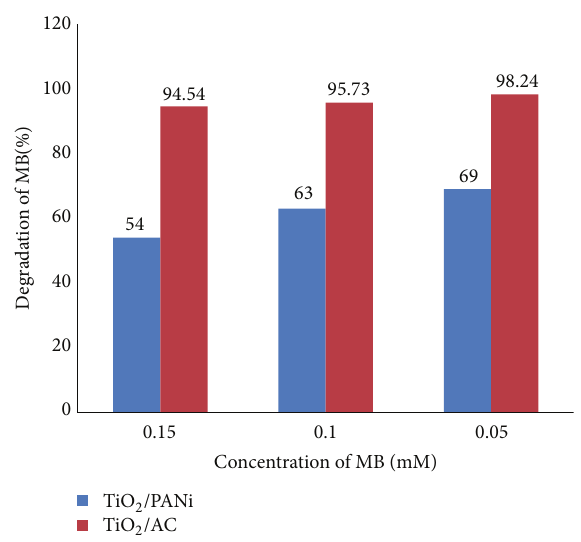
Figure 7: Effect of MB concentration on photocatalytic activity for TiO 2 /PANi and TiO 2 /AC.